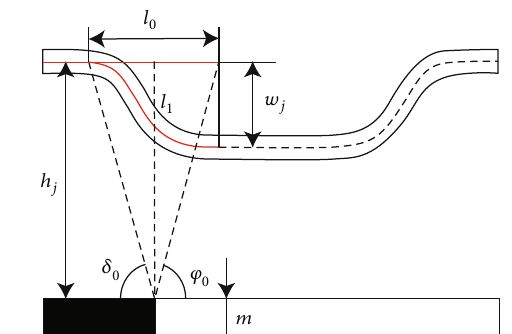
Figure 6: Sketch map of tensile deformation of rock